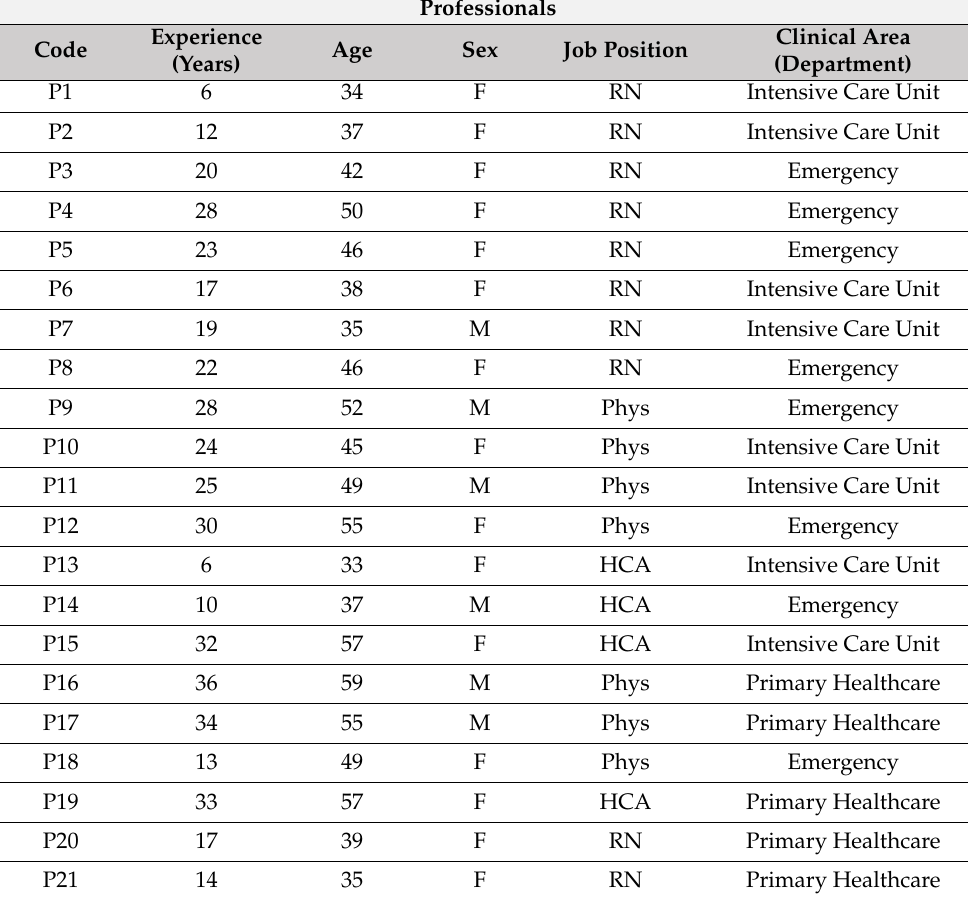
Table 1. Summary of each participant’s